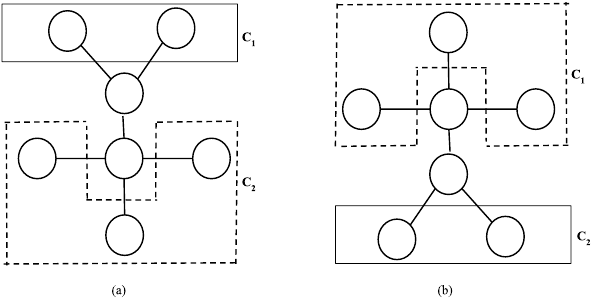
Figure 8. ( a ) When C 1 is chosen as C ∗ . ( b ) When C 2 is chosen as C ∗ . Table 1. Cost of removing nodes in D (cid:48) and D ∗ on millipede